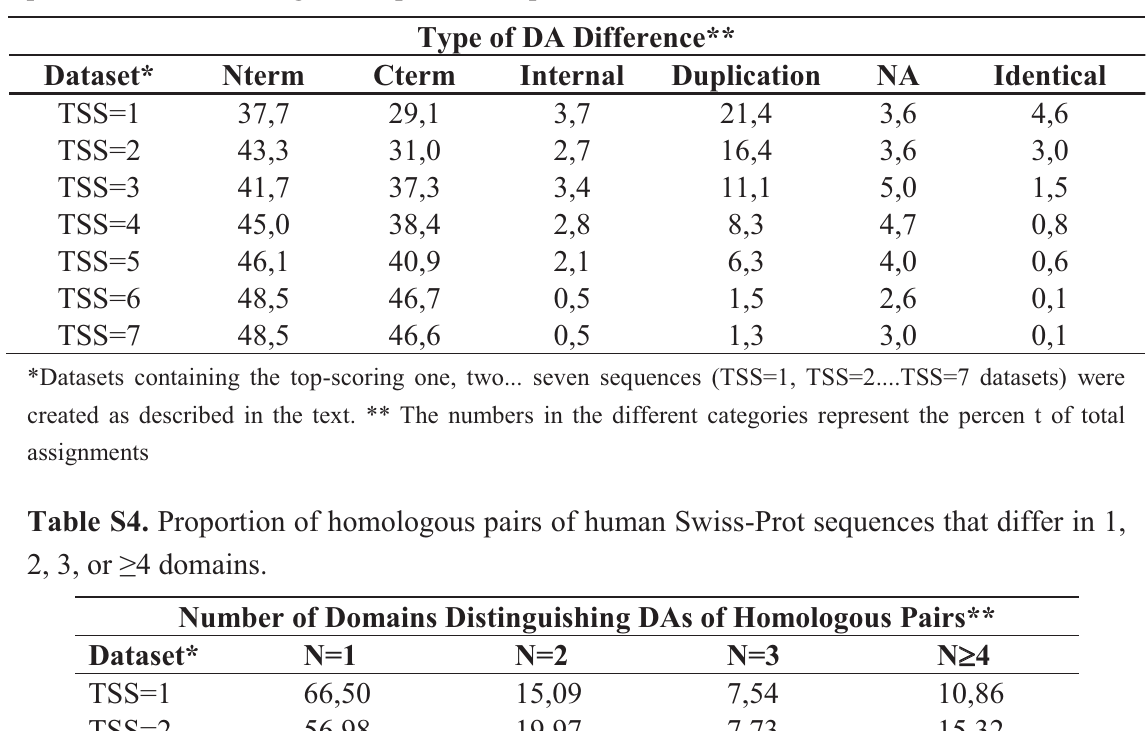
Table S3. Positional distribution of DA differences of paralogous human Swiss-Prot proteins defined through intraspecies comparisons.